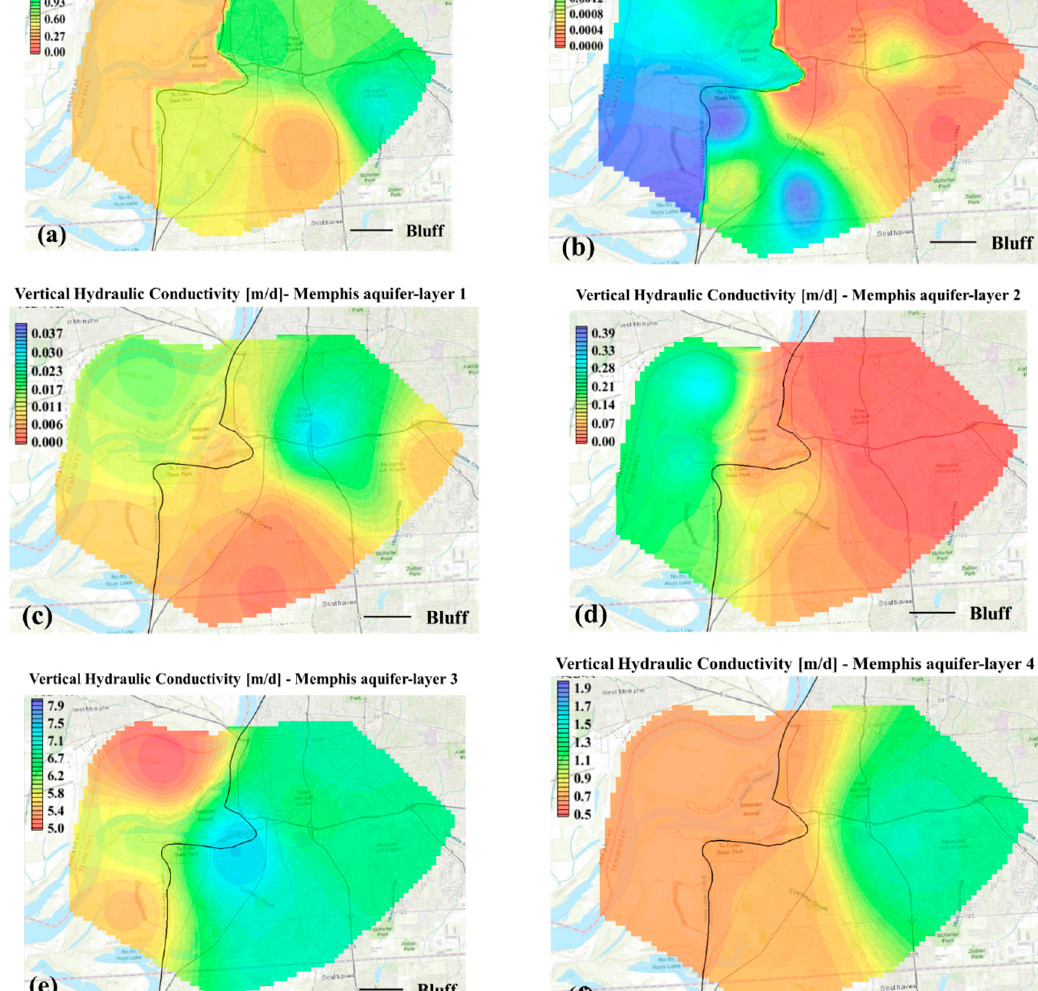
Figure A2. ( a – f ) The vertical hydraulic conductivities of each numerical layer.